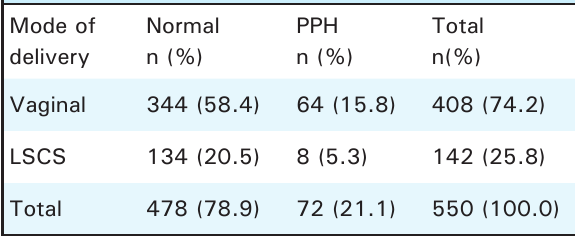
Table 2. Association between mode of delivery and